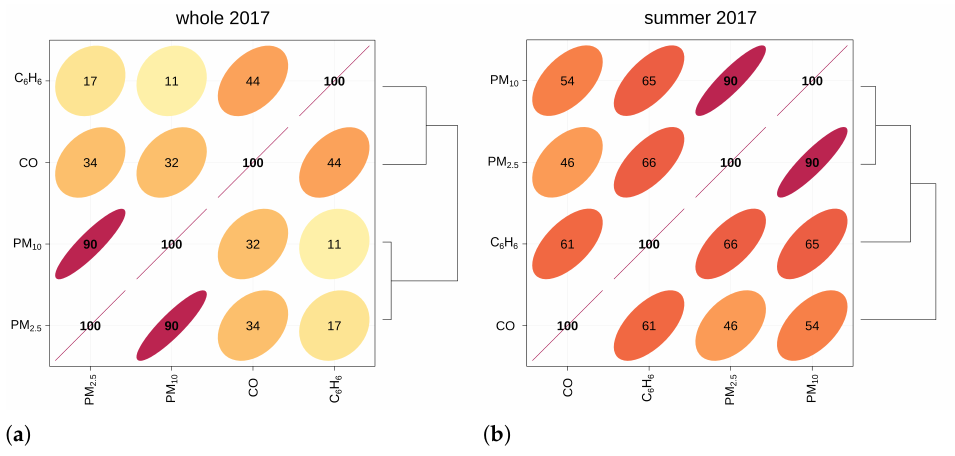
Figure 3. Spearman matrix correlation and dendrogram among PM 2.5 , PM 10 , CO and C 6 H 6 during: ( a ) the whole 2017, and ( b ) the summer